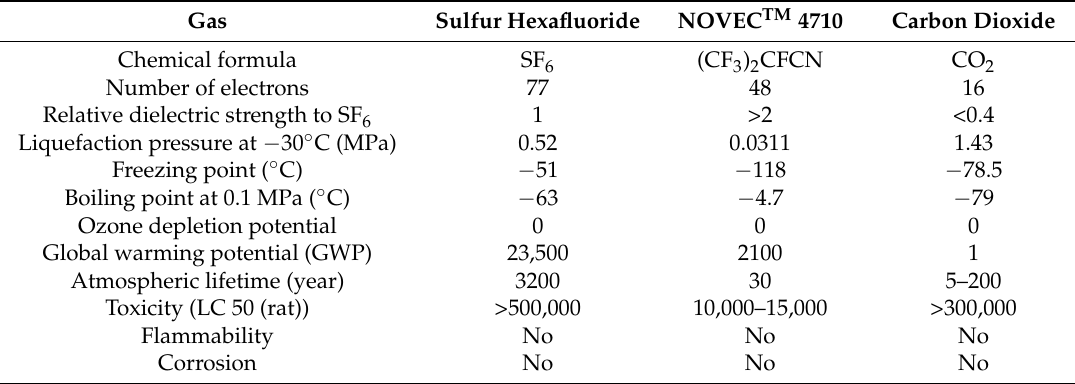
Table 1. Physical and chemical properties of